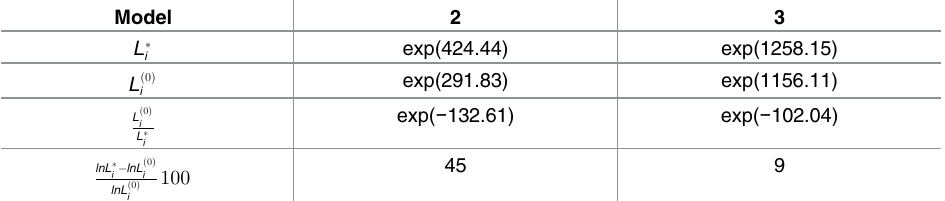
Table 14. Industry-specific tendency variables: Actual effect of block